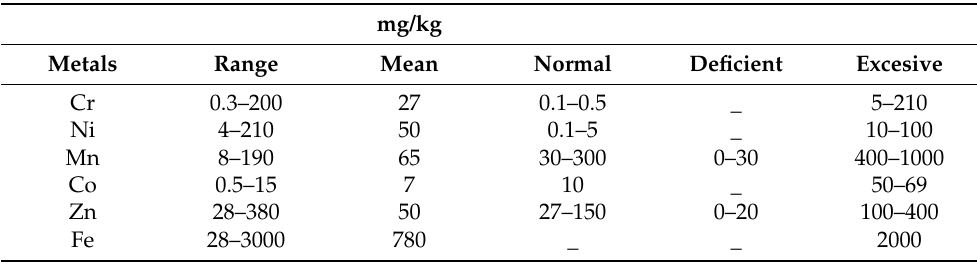
Table 2. Chromium, Ni, Mn, Co, Zn, and Fe range and mean in plants/crops from the C. Evia and Assopos–Thiva basins.